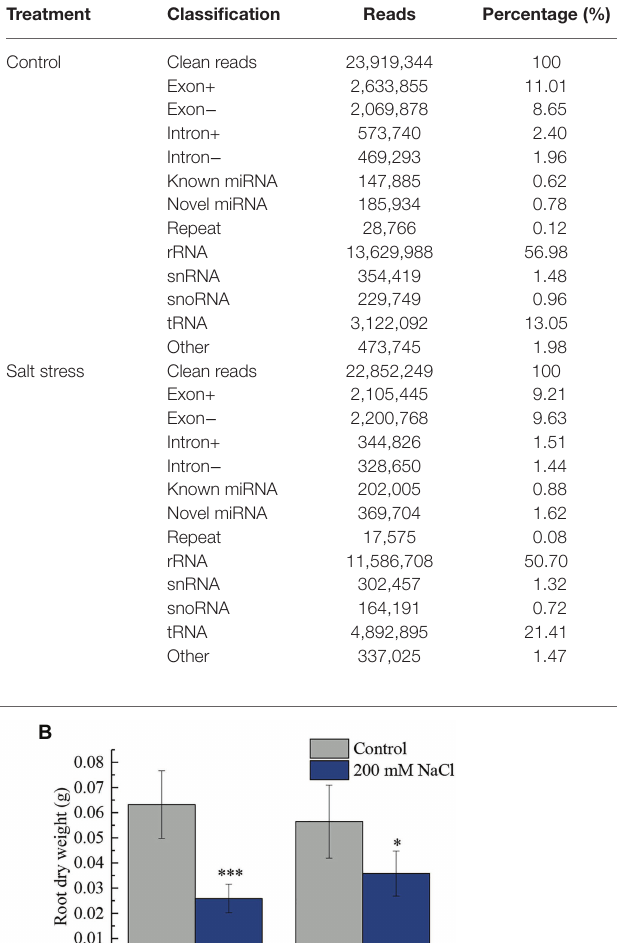
TABLE 1 | Summary of small RNA-seq data in QM6 under two treatments.